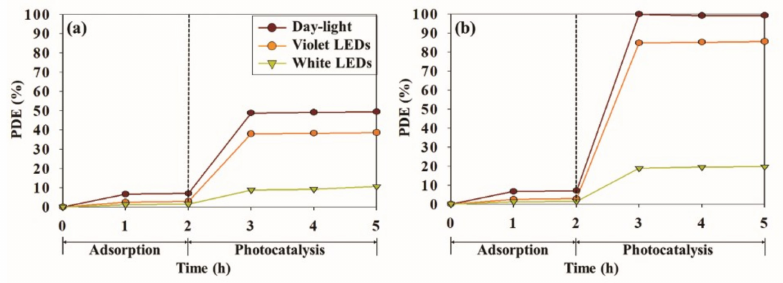
Figure 9. Photocatalytic decomposition e ffi ciencies (PDE, %) for ( a ) toluene and ( b ) o-xylene determined with CeT-0.75 under three types of light sources (conventional daylight lamp, violet light emitting diodes (LEDs), and white